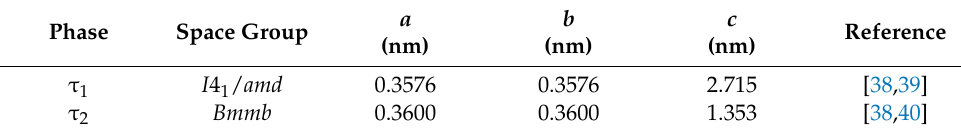
Table 5. Basic crystallographic parameters of τ 1 and τ 2